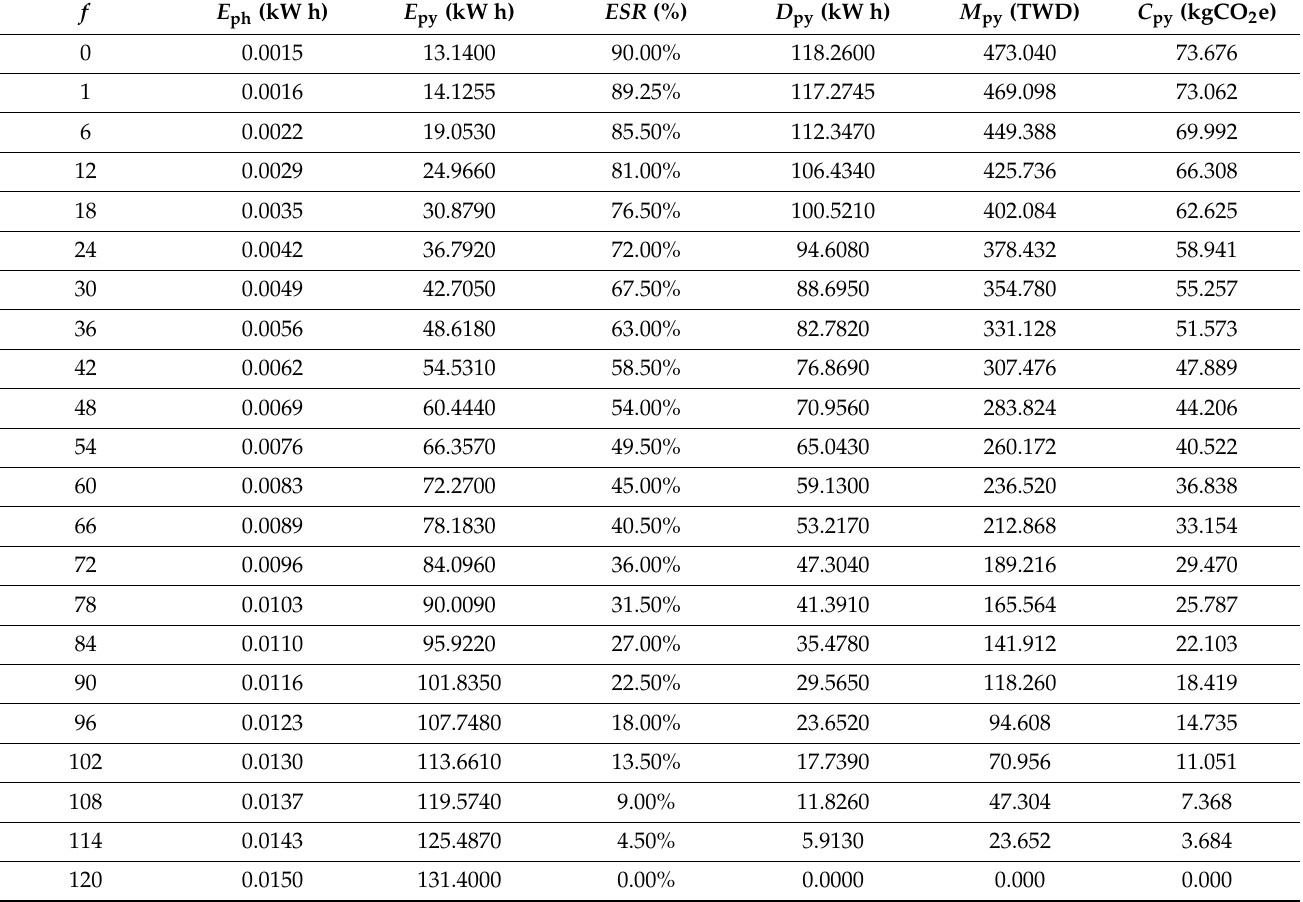
Table 7. E ph , E py , ESR , D py , M py , C py values of each proposed IoT-based intelligent LED light with different f